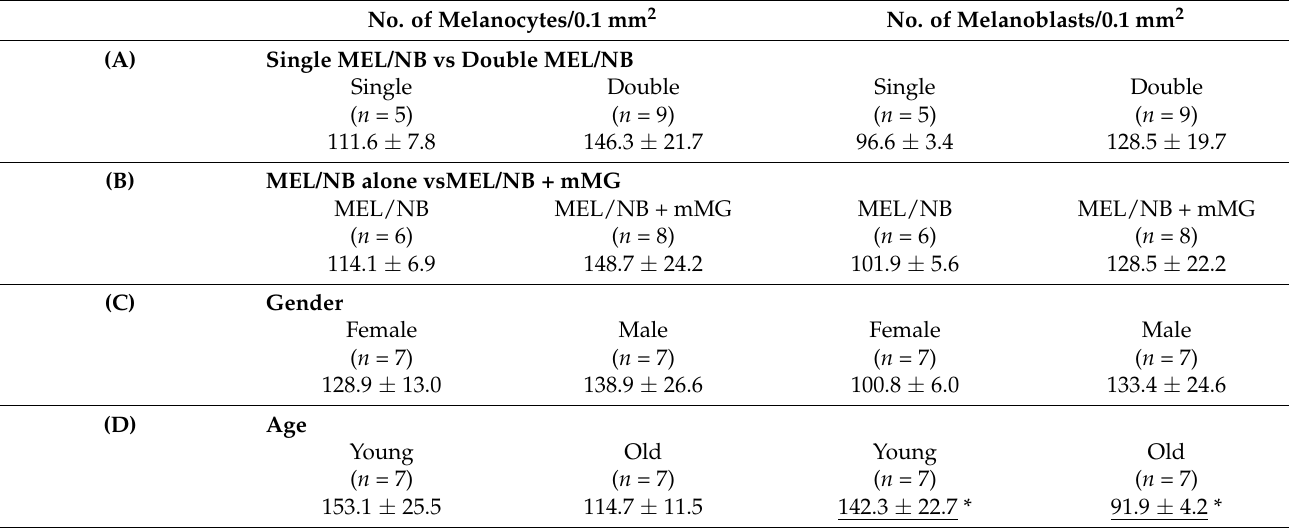
Table 2. The melanocyte and melanoblast populations in the epidermis of repigmented skin after phototherapy and/or skin